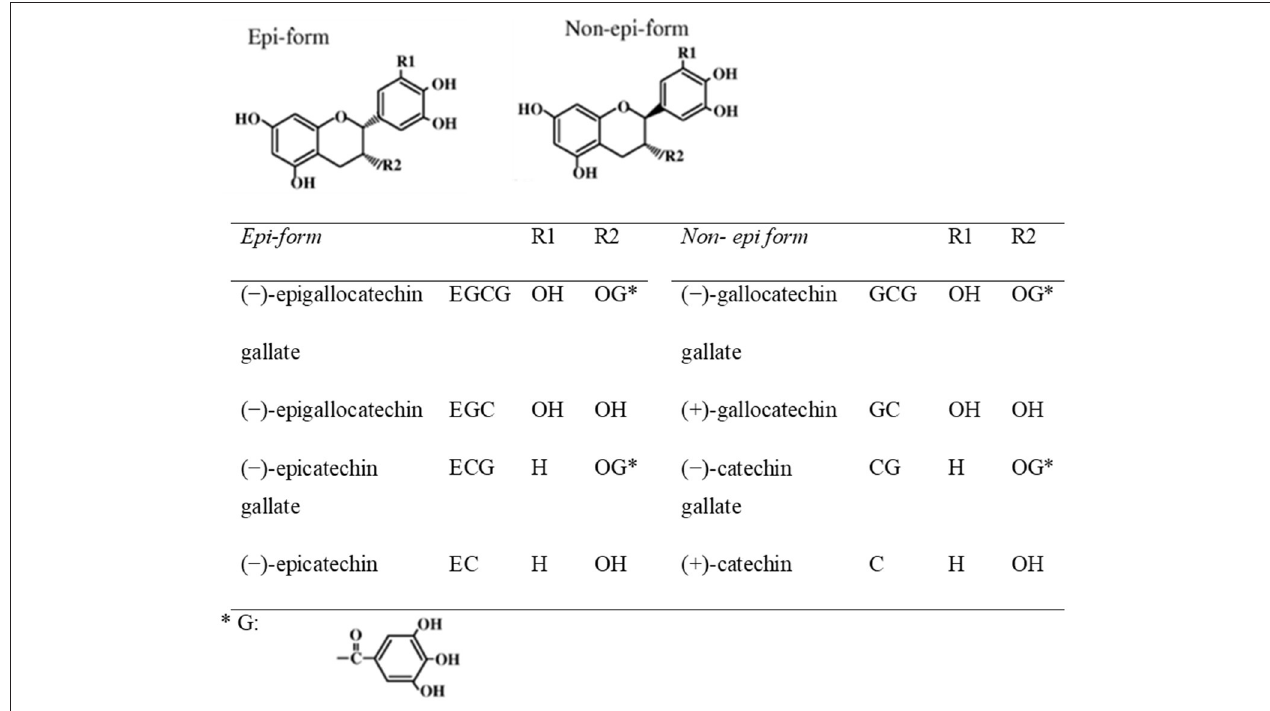
FIGURE 2 | Chemical structures of eight green tea catechins